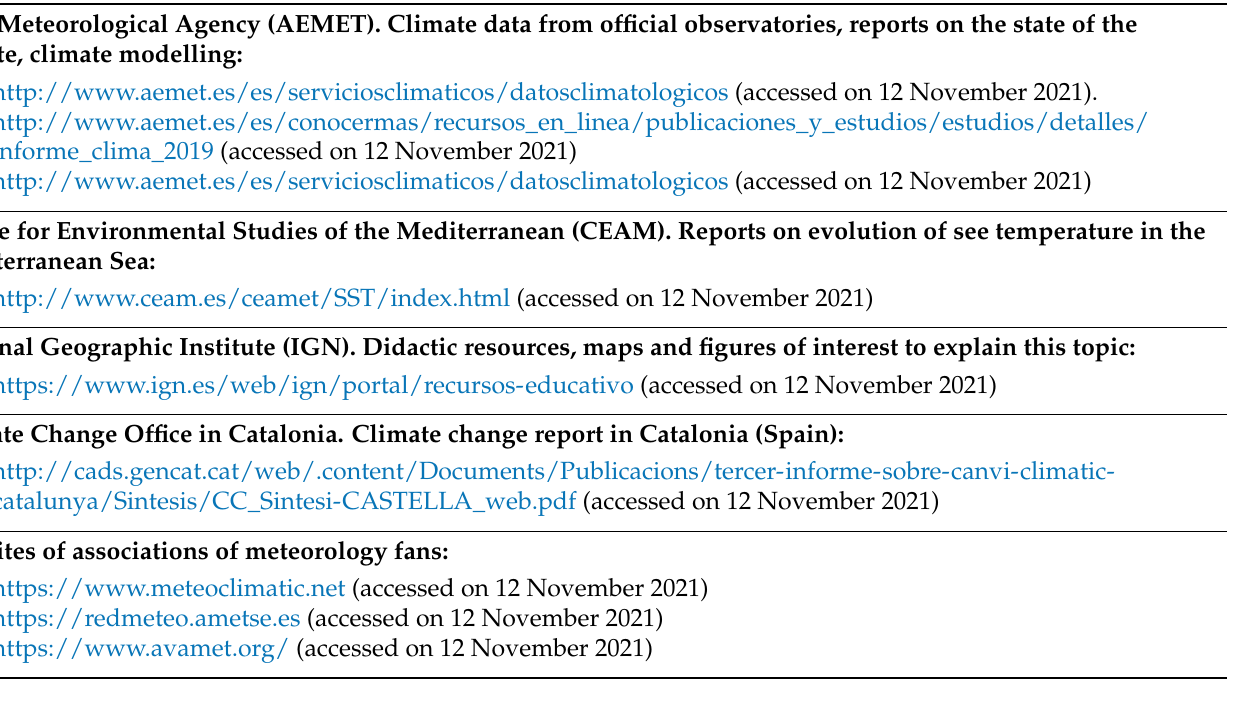
Table A1. Resources and Teaching Materials for Teachers and Students